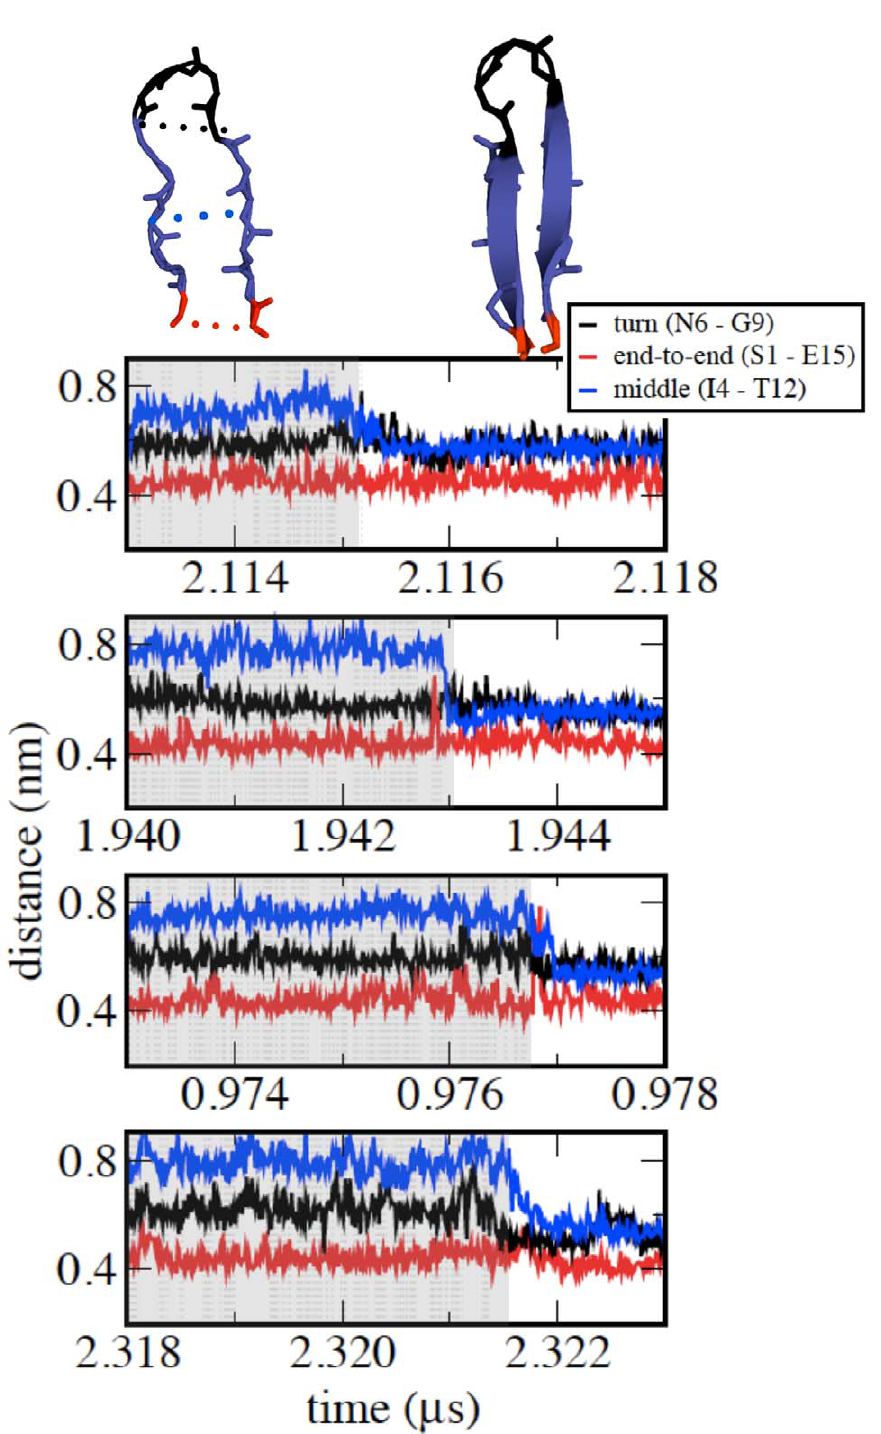
Figure 8. Representative forward reactive paths illustrating the events occurring after the TS. The TS region is shaded in grey. The time evolution of the distance between the C a atoms of the turn (N6-G9), end (S1-E15) and middle (I4-T12) residues are plotted in black, red and blue, respectively.